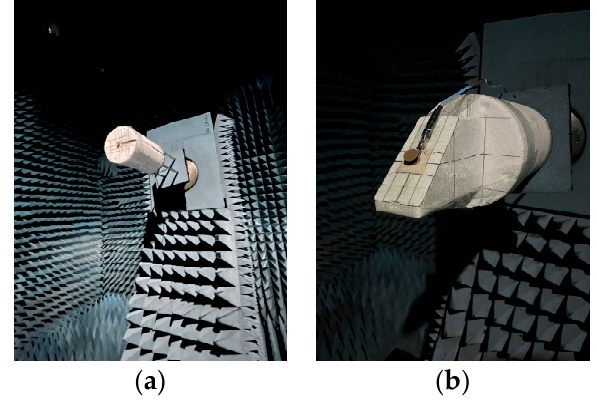
Figure 7. Measurements in anechoic chamber: ( a ) E plane and ( b ) H plane.